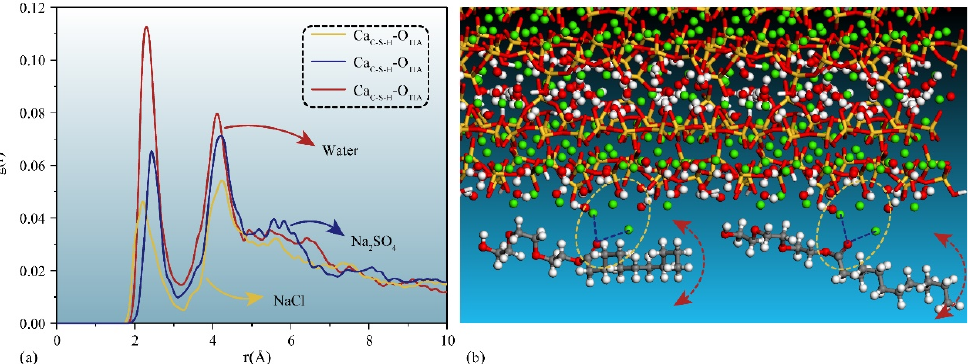
Figure 6. Interaction between TIA and C ‐ S ‐ H matrix surface in different solutions: ( a ) represents radial distribution functions of oxygen atoms in TIA and calcium ions on the surface of C ‐ S ‐ H matrix in different solutions, ( b ) indicates the binding of TIA to calcium ion. The red, green, yellow, white and gray spheres represent oxygen atoms, calcium atoms, silicon atoms, hydrogen atoms and car ‐ bon atoms, respectively.